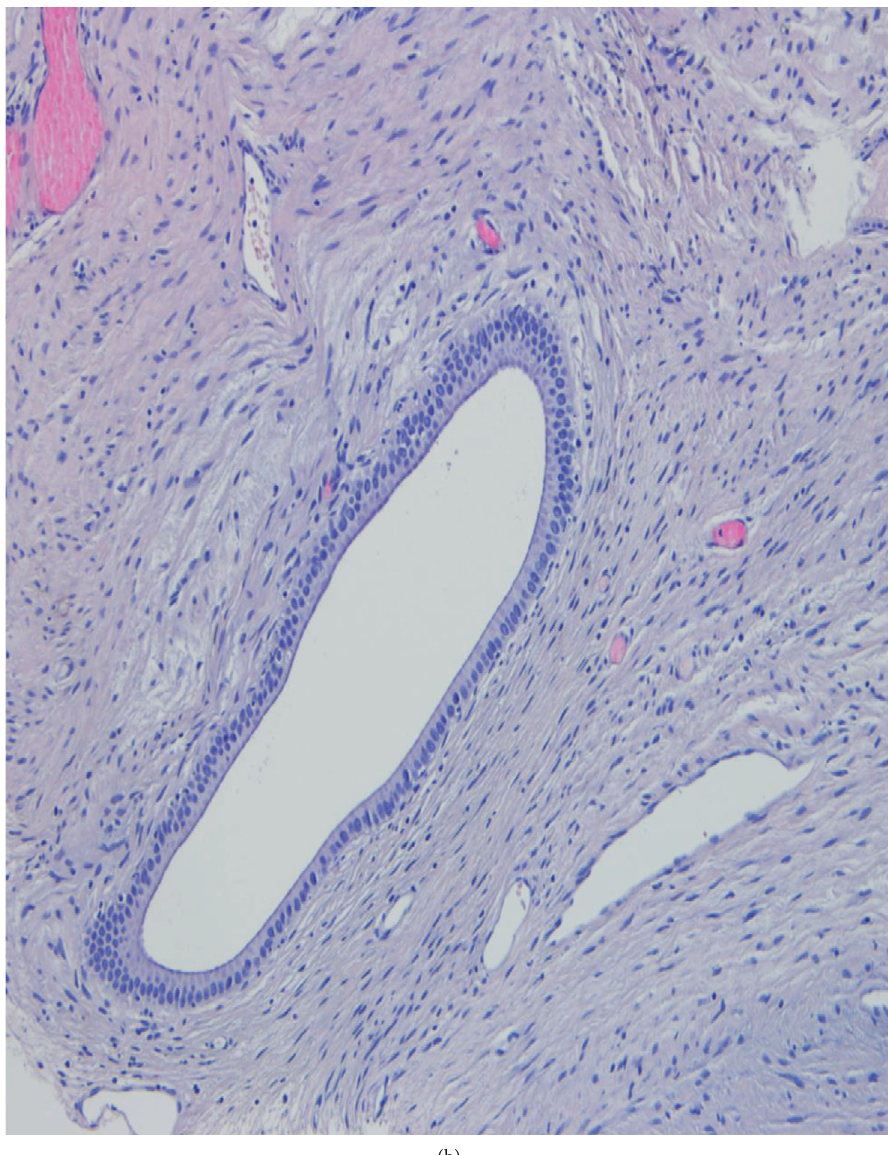
Figure 8: Lymph node metastases from germ neoplasia with characteristics of mature teratoma with components from the three germinal layers (a, b, H&E